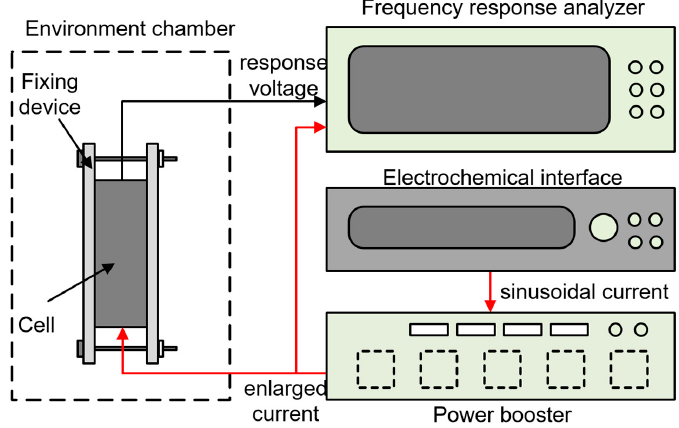
Figure 8. Diagram of battery electrochemical impedance spectroscopy (EIS) experiment without the temperature